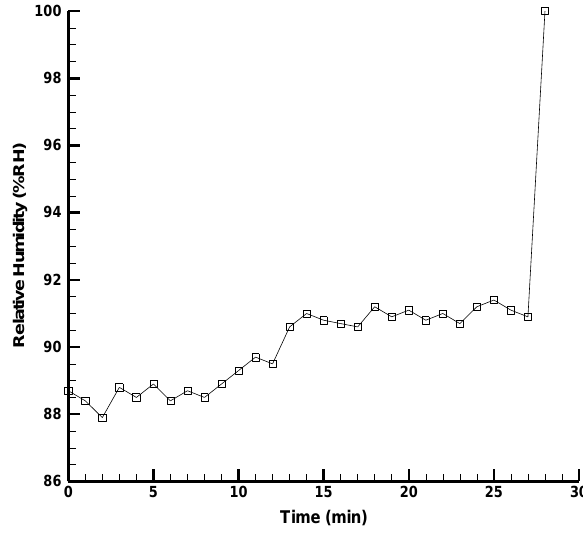
Figure 10. The humidity diagnosis within fuel cell using wireless sensing